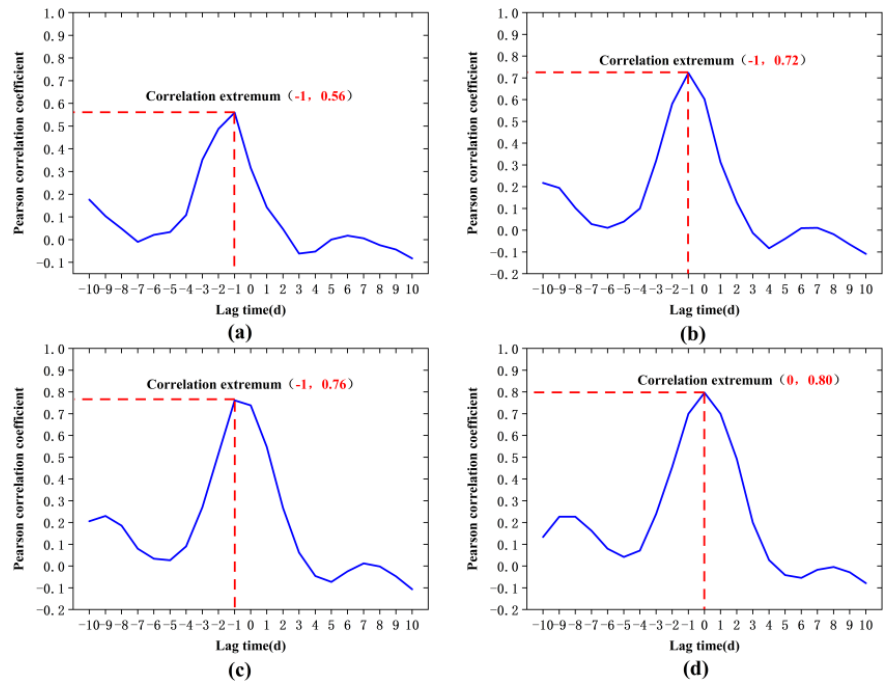
Figure 16. ( a ) Single-day rainfall; ( b ) two-day cumulative rainfall; ( c ) three-day cumulative rainfall; and ( d ) four-day cumulative rainfall and deformation rate time lag intercorrelation series. Similar to rainfall, soil moisture content is also an important factor influencing land- slide deformation. As the soil moisture content increased, the self-weight and sliding force of the landslides increased, while the friction force decreased, which led to accelerated landslide deformation. The cumulative deformation and soil water content for the corre- sponding periods at monitoring site BZ01 were analysed, and the results are shown in Figure 17. Both the measured soil water content and GNSS-interpreted soil water content showed a significant increase in soil water content at the three deformation occurrences,